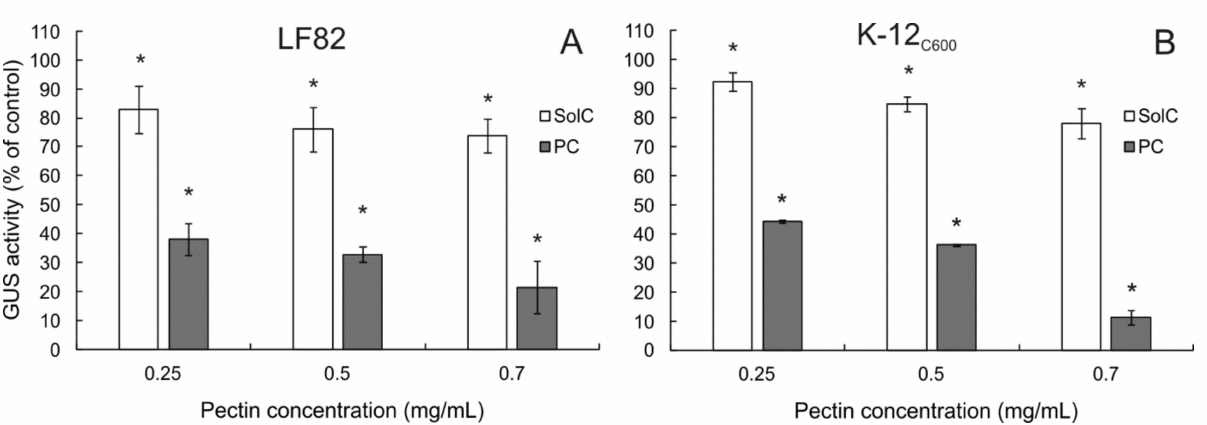
Figure 9. The influence of pectins on GUS activity in E. coli LH82 ( A ) and K-12 C600 lysates ( B ). Pectin solution were mixed with 0.5 U of E. coli GUS and incubated for 18 h. The means of three experiments ± SD are presented (* p < 0.05). Statistical significance was checked between the studied probes and controls (no pectin) assumed to be